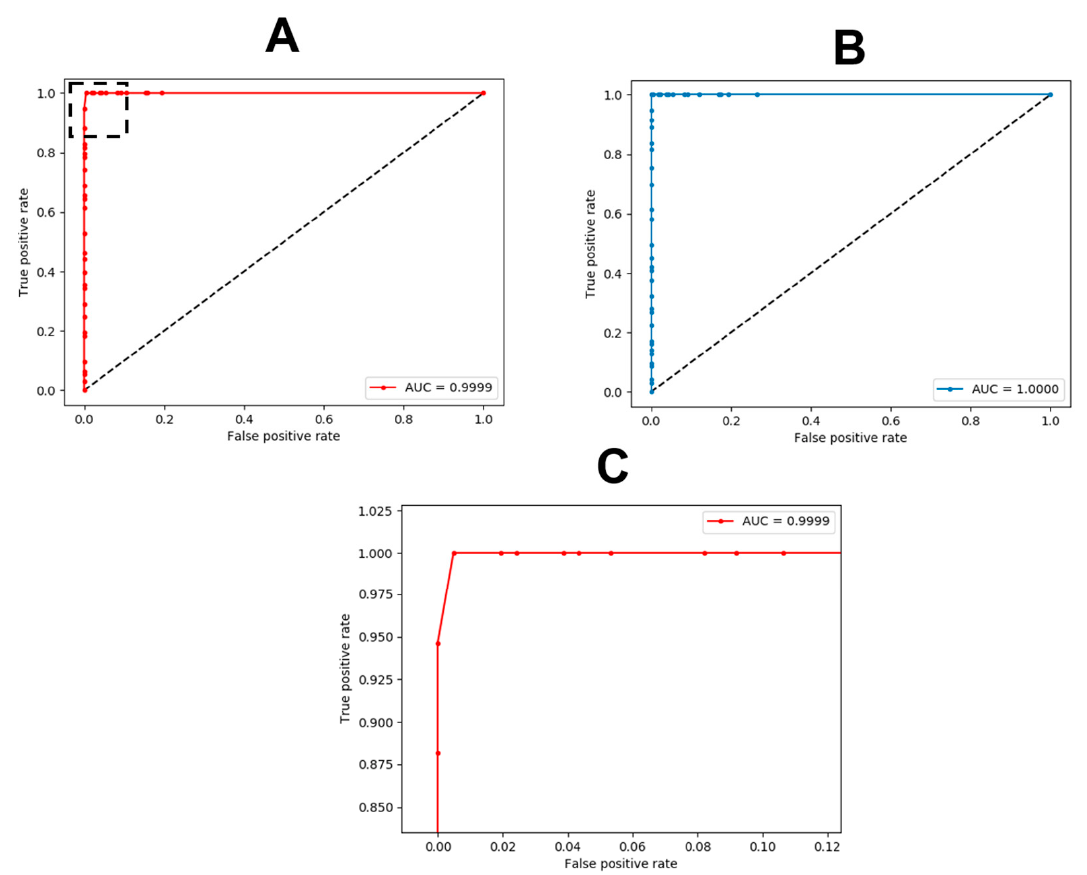
Figure 6. ROC curves with AUC values for Neural Network performance. ( A ) Worst recorded performance of the Neural Network model, obtaining an AUC of 0.9999. ( B ) best recorded performance of the Neural Network model, obtaining an AUC of 1. ( C ) Detail of dotted-square in ( A ), showing the slight perfection a ff ecting this model’s achievement of a perfect right-angle